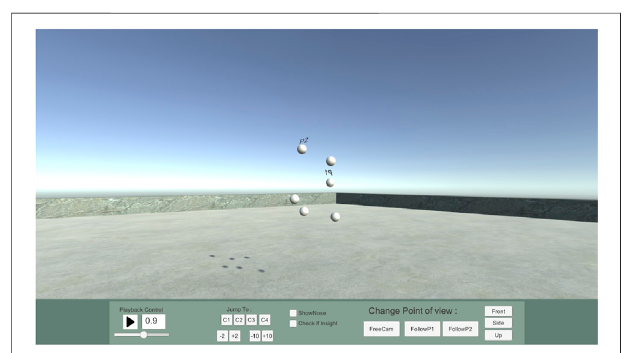
FIGURE 8 | The user interface named as the “ Viewer ” , where one can watch a live or past performance from a third point of